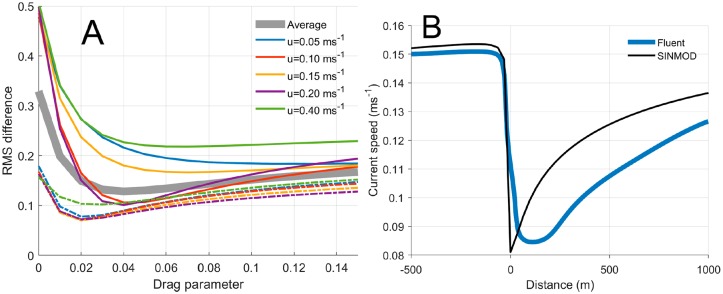
Estimating the drag parameter.A: The RMS difference in current speeds calculated by Eq (5) along lateral horizontal cross sections (Fig 4) at 10 (solid curves) and 20 (dashed curves) m depth between the SINMOD and FLUENT ® simulations. B: current speeds along the lateral transect in Fig 4 at 10 m depth, from FLUENT ® (blue) and SINMOD (black). Distances are relative to the center of the cage (Fig 4).